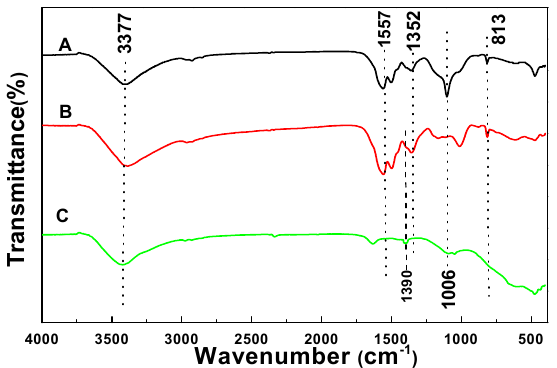
Figure 1. Fourier-transformation infrared (FTIR) spectra of A pure melamine formaldehyde (MF) microspheres, B MF@C-TiO 2 core-shell microspheres and C the resulting C-TiO 2 hollow microspheres.